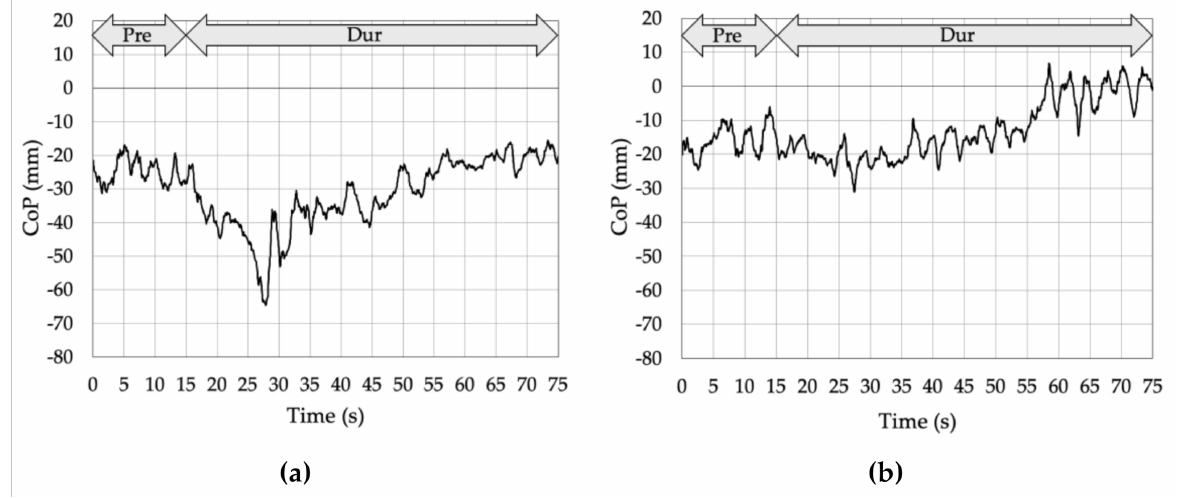
Figure 6. Results of CoP displacement of the patient 6 in the anteroposterior direction: (a) CoP displacement when the vibratory stimulation was applied to the GS; (b) CoP displacement when the vibratory stimulation was applied to the LM.